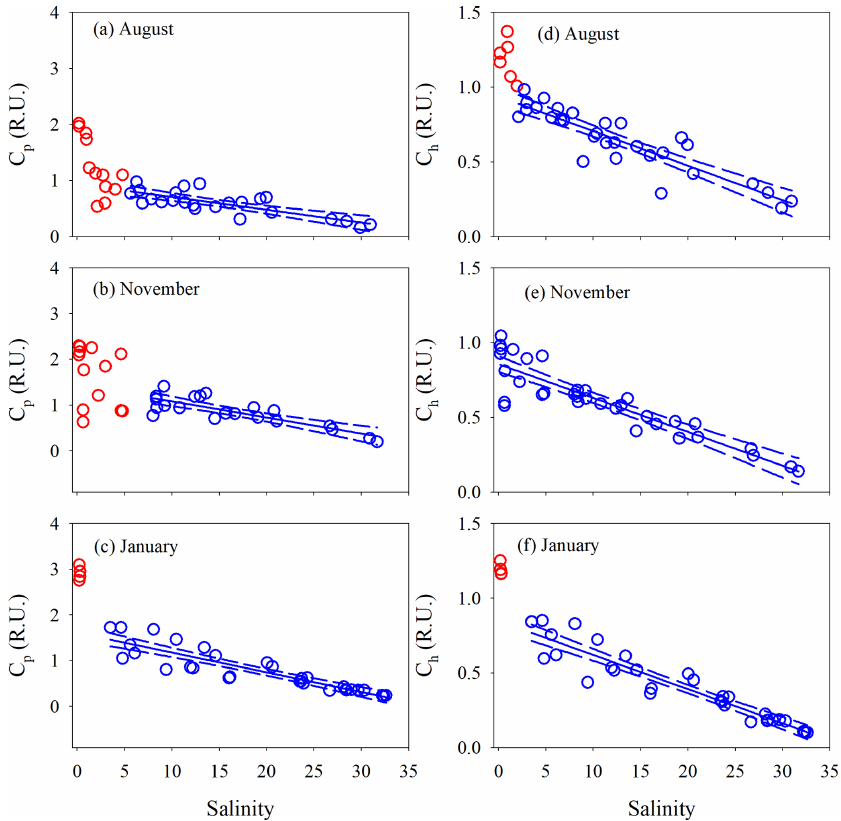
Figure 6. Same as in Fig. 5b, d, and e–g except for FDOM components C p and C h